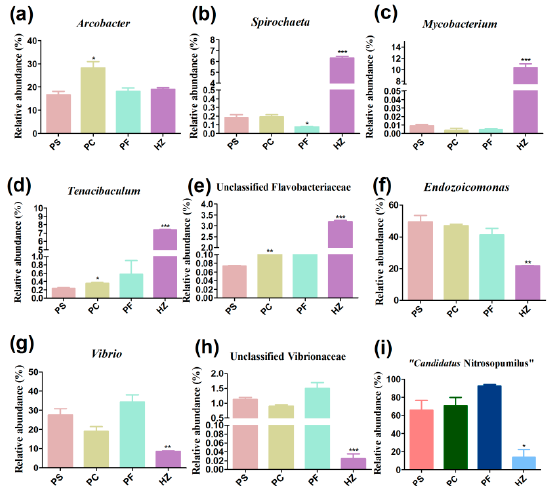
Figure 3. Relative abundances of the most abundant genera in each sample. Significant differences across PS and other samples are indicated with “*”. “*”, p < 0.05; “**”, p < 0.01; “***”, p < 0.001. ( a ) Relative abundance of Arcobacter in each sample. ( b ) Relative abundance of Spirochaeta in each sample. ( c ) Relative abundance of Mycobacterium in each sample. ( d ) Relative abundance of Te- nacibaculum in each sample. ( e ) Relative abundance of unclassified Flavobacteriaceae in each sample. ( f ) Relative abundance of Endozoicomonas in each sample. ( g ) Relative abundance of Vibrio in each sample. ( h ) Relative abundance of unclassified Vibrionaceae in each sample. ( i ) Relative abundance of “ Candidatus Nitrosopumilus” in each sample.